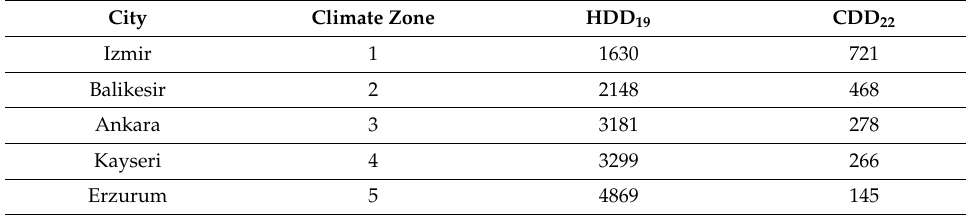
Table 2. Heating (HDD) and Cooling (CDD) Degree-days for selected cities [31,36].